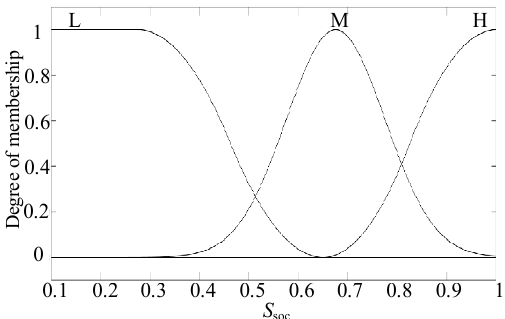
Figure 8. Membership function of S SOC .